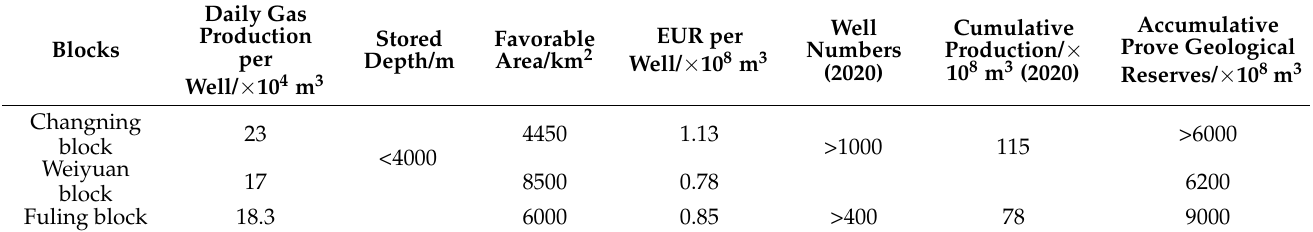
Table 1. Production overview of the Changning, Weiyuan, and Fuling shale demonstration blocks